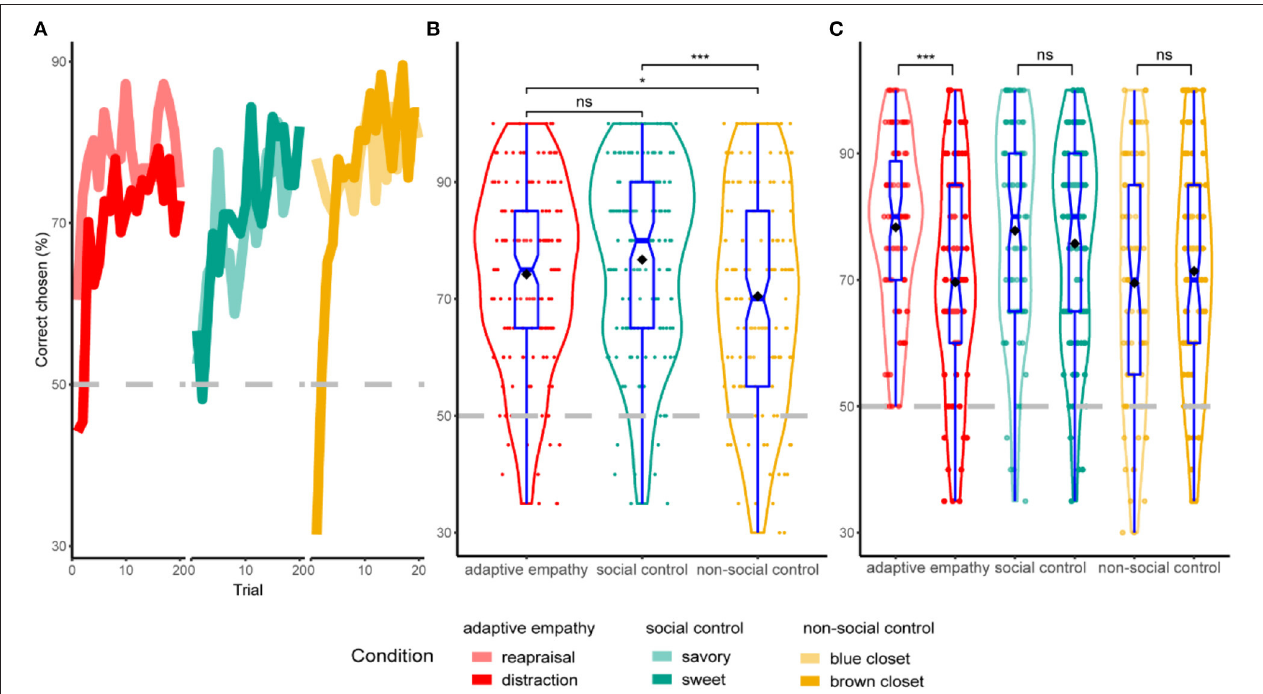
FIGURE 2 | Learning accuracy between conditions. (A) Group-level learning curves showing choice behavior in the three learning conditions. Trials are averaged over the three conditions for adaptive empathy, social control, and non-social control. Dashed lines indicate chance level. (B) Comparison of accuracy between the three conditions. Participants exhibited significantly higher learning accuracy in social vs. non-social and in adaptive empathy vs. non-social control conditions. (C) Comparison of learning accuracy within each condition, between strategies preferred by the target. Participants exhibited significantly higher learning accuracy when learning that targets preferred reappraisal over distraction. * p ≤ 0.05, *** p ≤ 0.001, ns, not